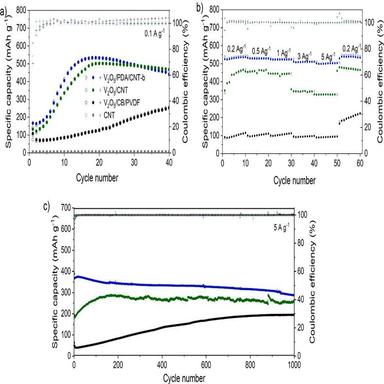
(a) Cycling performance at 0.1 A g− 1 , (b) rate capability and (c) long cycling performance at 5 A g− 1 of V2O5/CB/PVDF, V2O5/CNT and V2O5/PDA/CNTb electrodes.